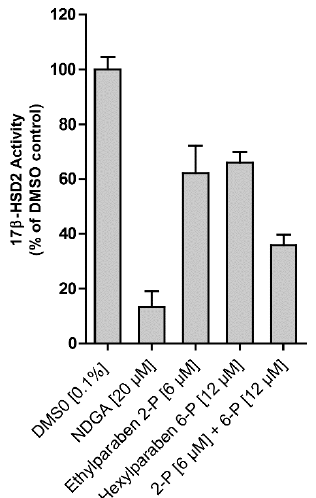
Figure 5. Additive inhibitory effects of two parabens on 17 β -HSD2 activity. The effect of 6 µ M ethyl- (2-P) or 12 µ M hexylparaben (6-P) or a mixture of both compounds on 17 β -HSD2 activity was assessed in lysates of transiently-transfected HEK-293 cells. Dimethylsulfoxide (DMSO) vehicle served as a negative control and nordihydroguaiaretic acid (NDGA) as a positive control [19]. Experiments were performed three times, independently. Statistical analyses were performed using one-way ANOVA followed by a Dunnett post-hoc test. Both tested parabens and the combination significantly inhibited 17 β -HSD2 ( p ≤ 0.01).